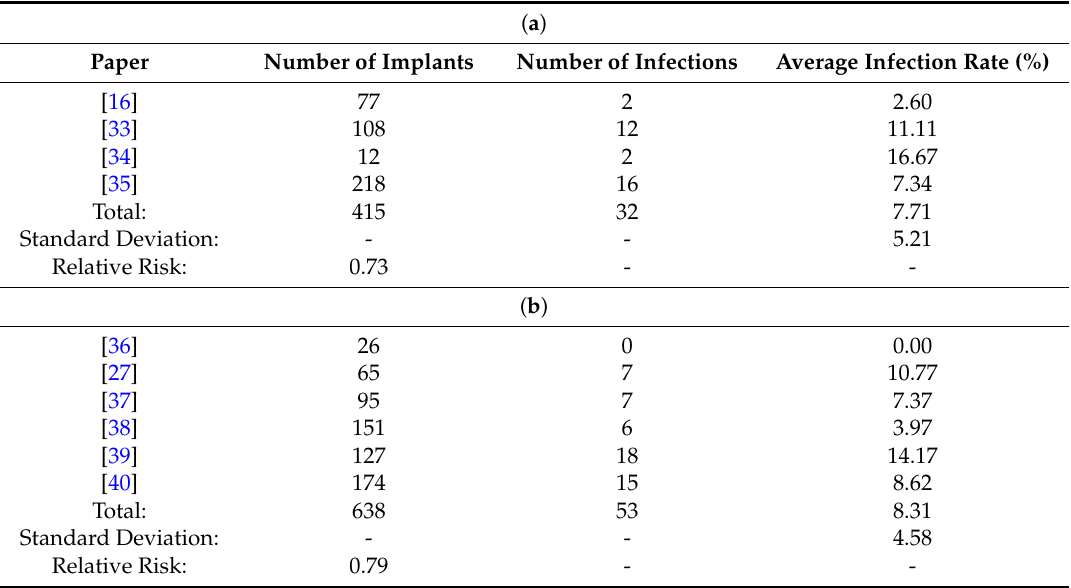
Table 5. ( a ) Titanium mesh; ( b ) Titanium